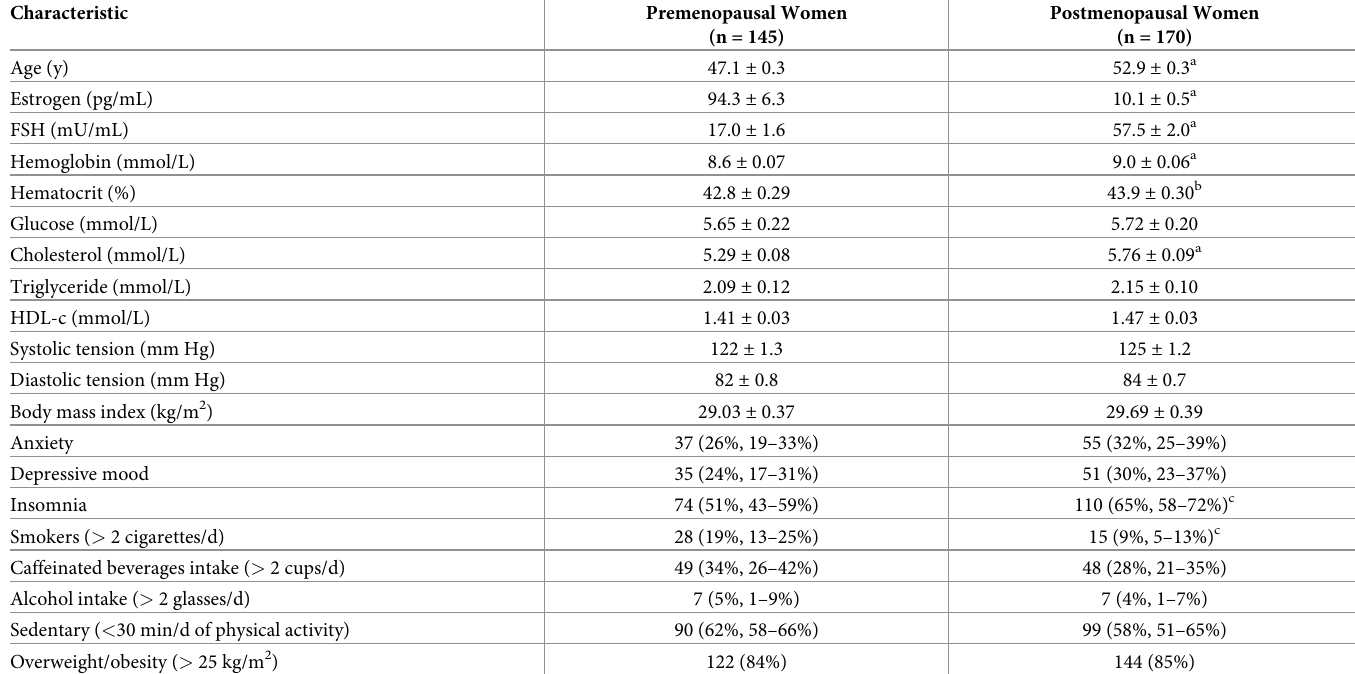
Table 1. Descriptive characteristics of study